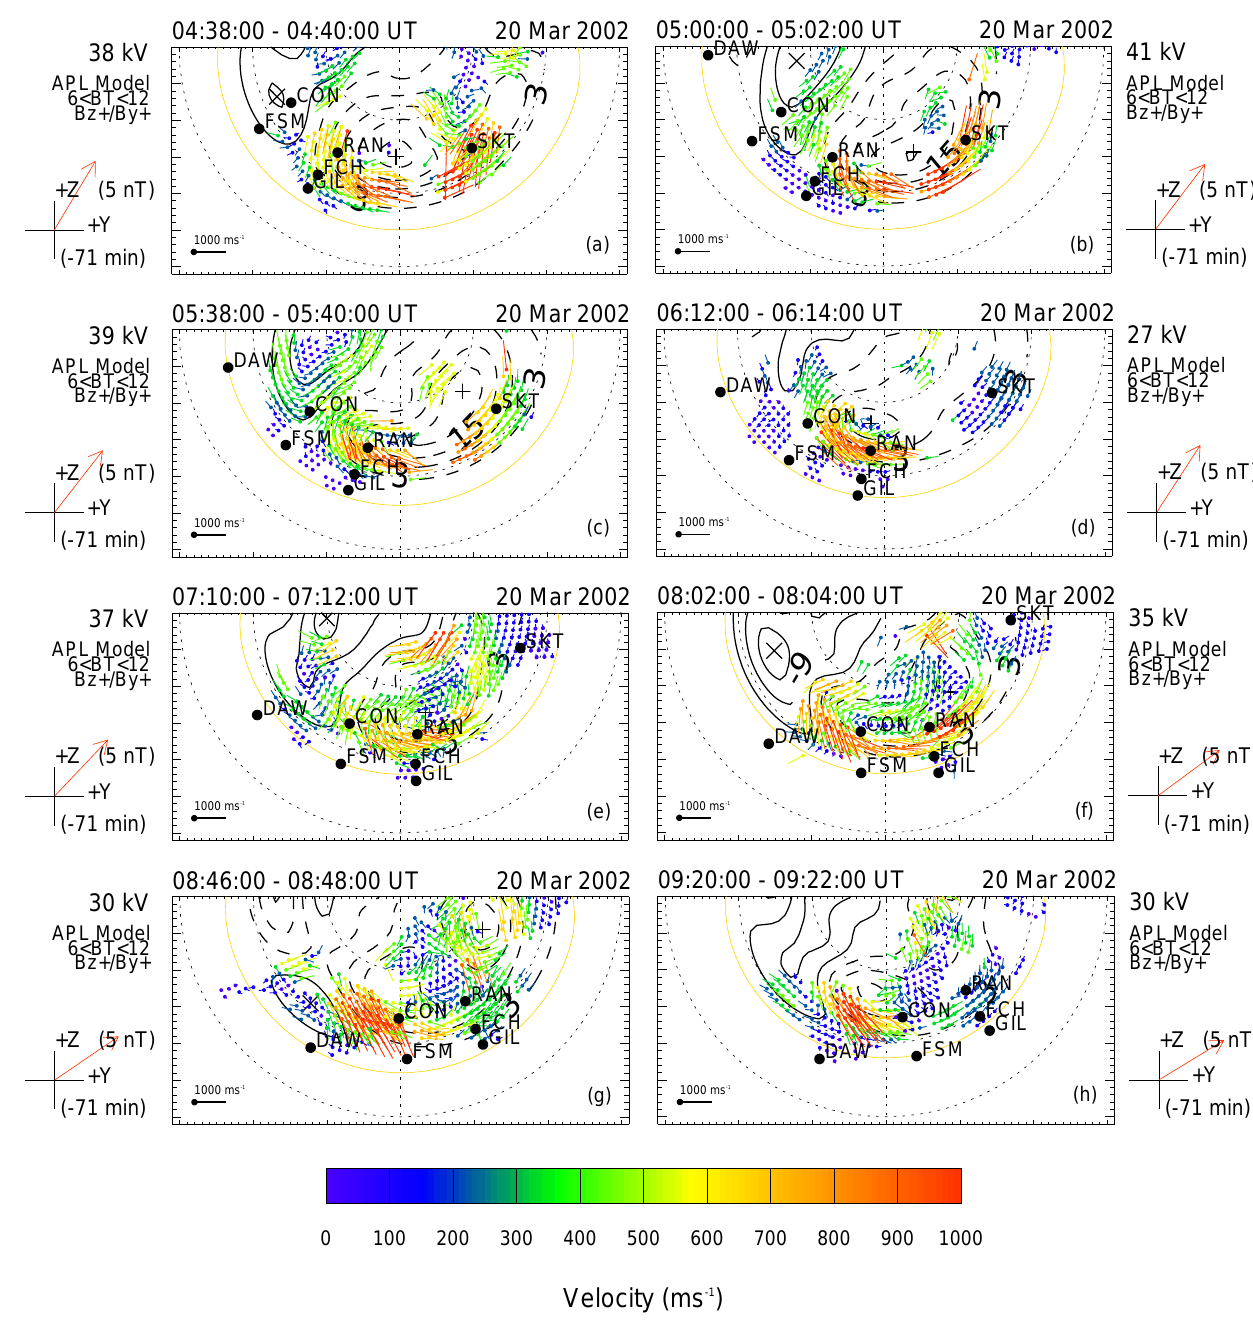
Fig. 5. Flow maps illustrating the flow “bursts” from the main interval are shown in the same format as Fig. 1. Eight maps are shown with the exact time of each 2-min map again indicated in the top left-hand corner. Also indicated on the maps by the black circles are the locations of the magnetometer stations colour-coded red in Fig.